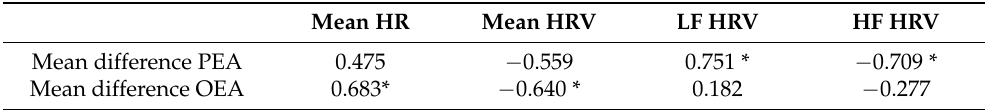
Table 5. Correlations between mean difference of ligands of eCB and time and frequency domains of HRV. Mean HR Mean HRV LF HRV HF HRV Mean difference PEA 0.475 − 0.559 0.751 * − 0.709 * Mean difference OEA 0.683* − 0.640 * 0.182 −